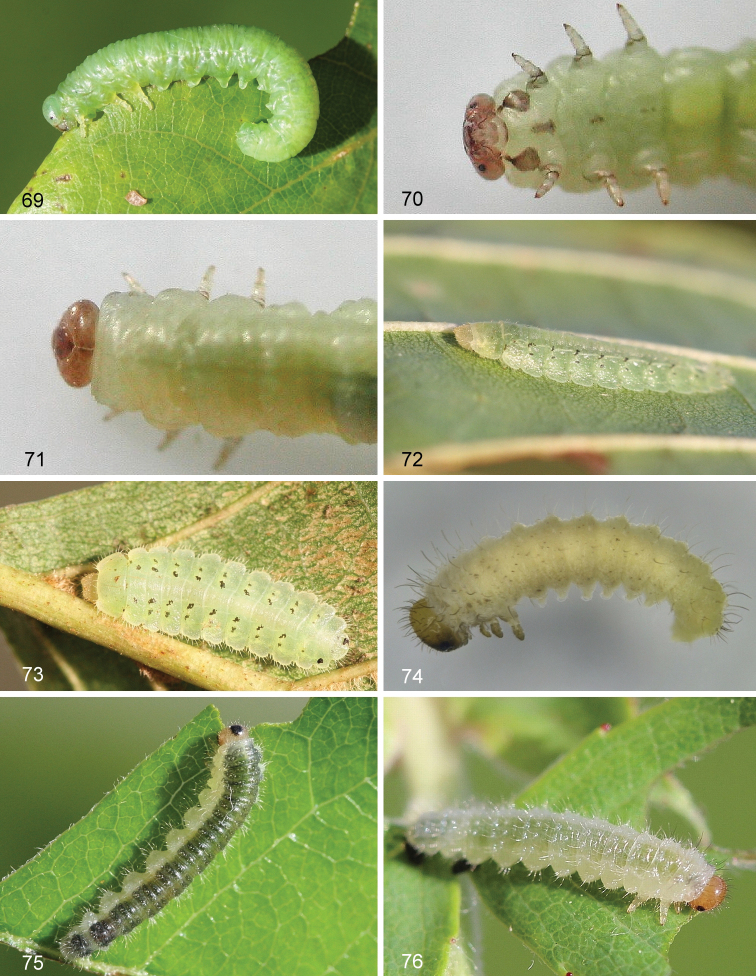
Larvae of Nematinae69Mesoneura
opaca70–71Pseudodineura
clematidis; ventral, dorsal 72–73Platycampus
luridiventris74Pristiphora
malaisei from Dryas
octopetala75Cladius
compressicornis76Cladius
pectinicornis.